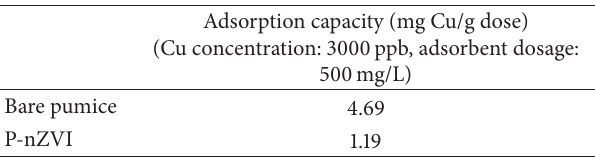
Table 4: Adsorption capacities of pumice and P-nZVI.